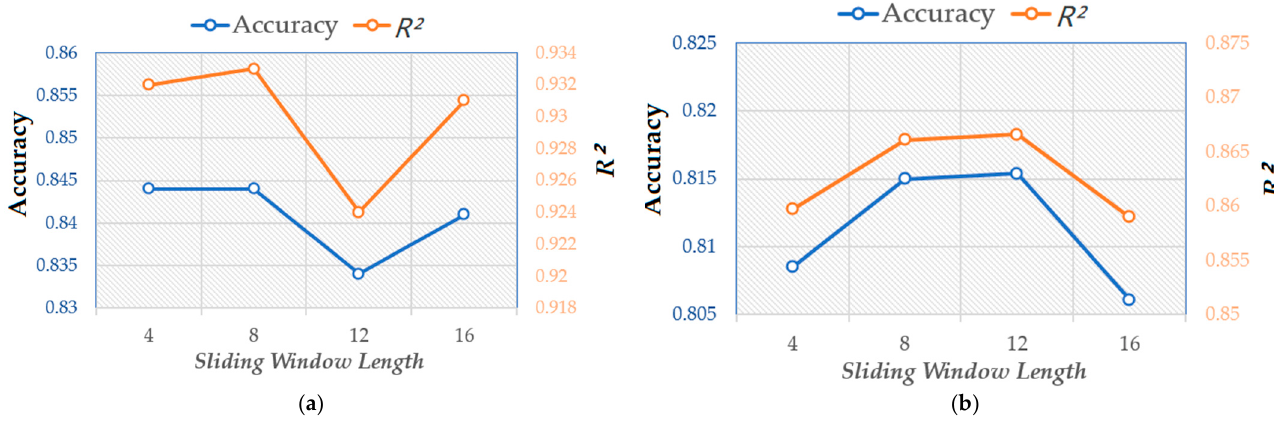
Figure 8. Performance comparison for different values of the sliding window lengths ( a ) Changes in accuracy and 2 R based on working days; ( b ) Changes in accuracy and 2 R based on holidays. Table 1. Prediction results for different length sliding windows.